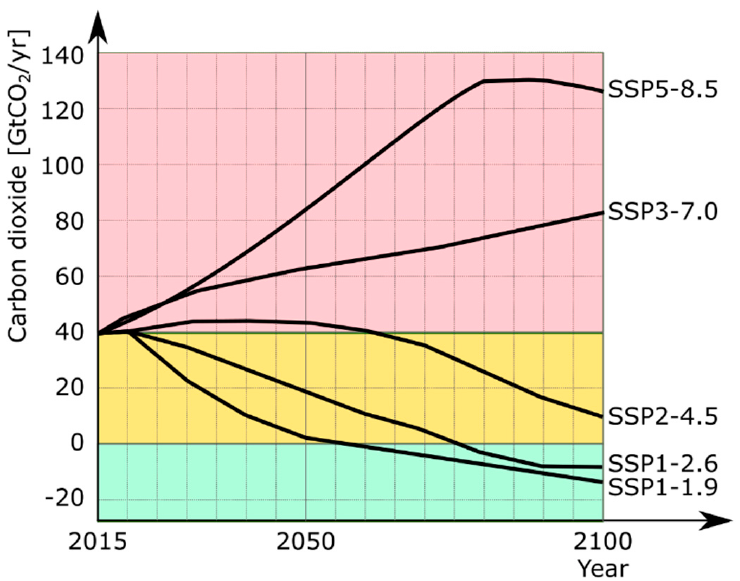
Figure 2. Prediction of future development of anthropogenic carbon dioxide in the current century (data source: [3]).